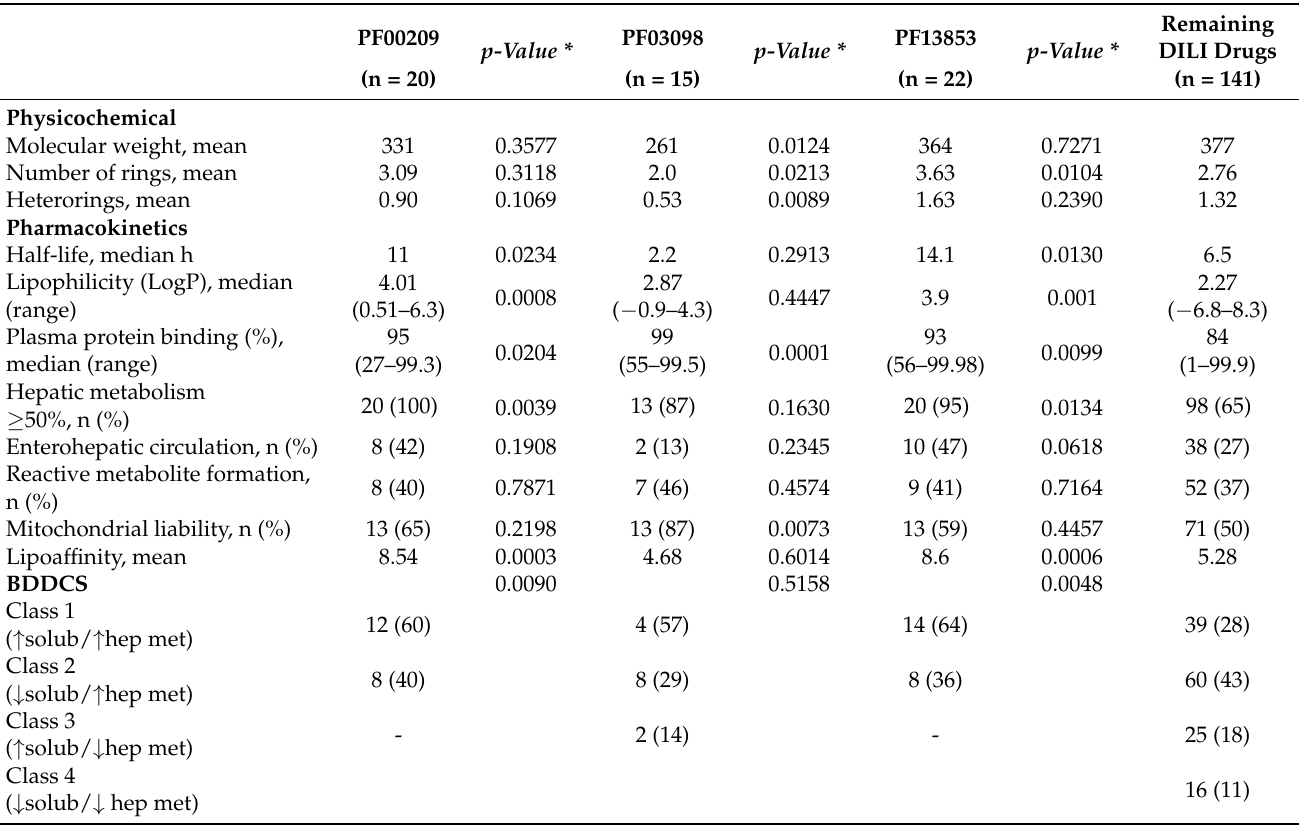
Table 3. Physicochemical, pharmacokinetic and pharmacodynamics properties of drugs based on their classification (community or therapeutic